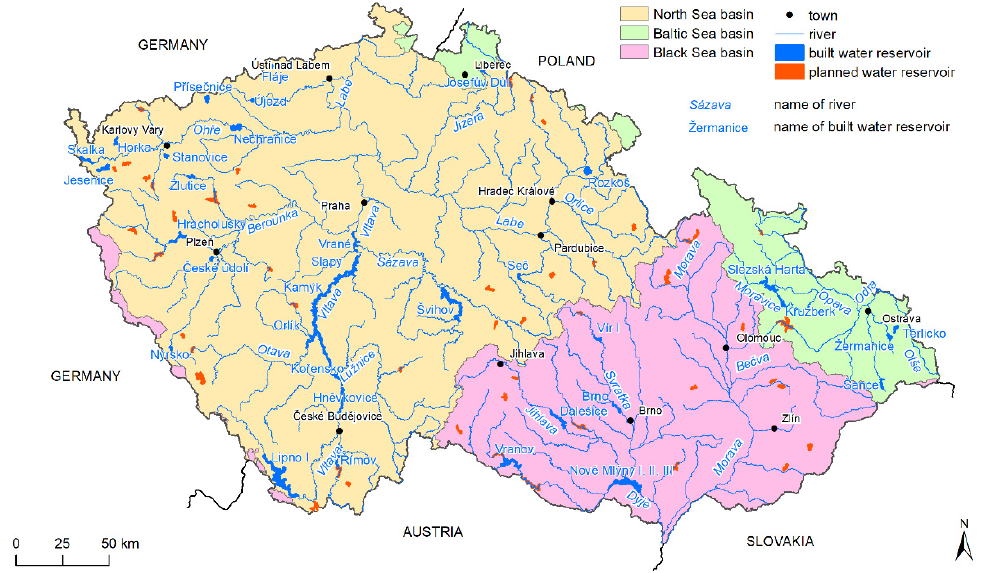
Figure 2. The completed and planned water reservoirs in the Czech Republic.